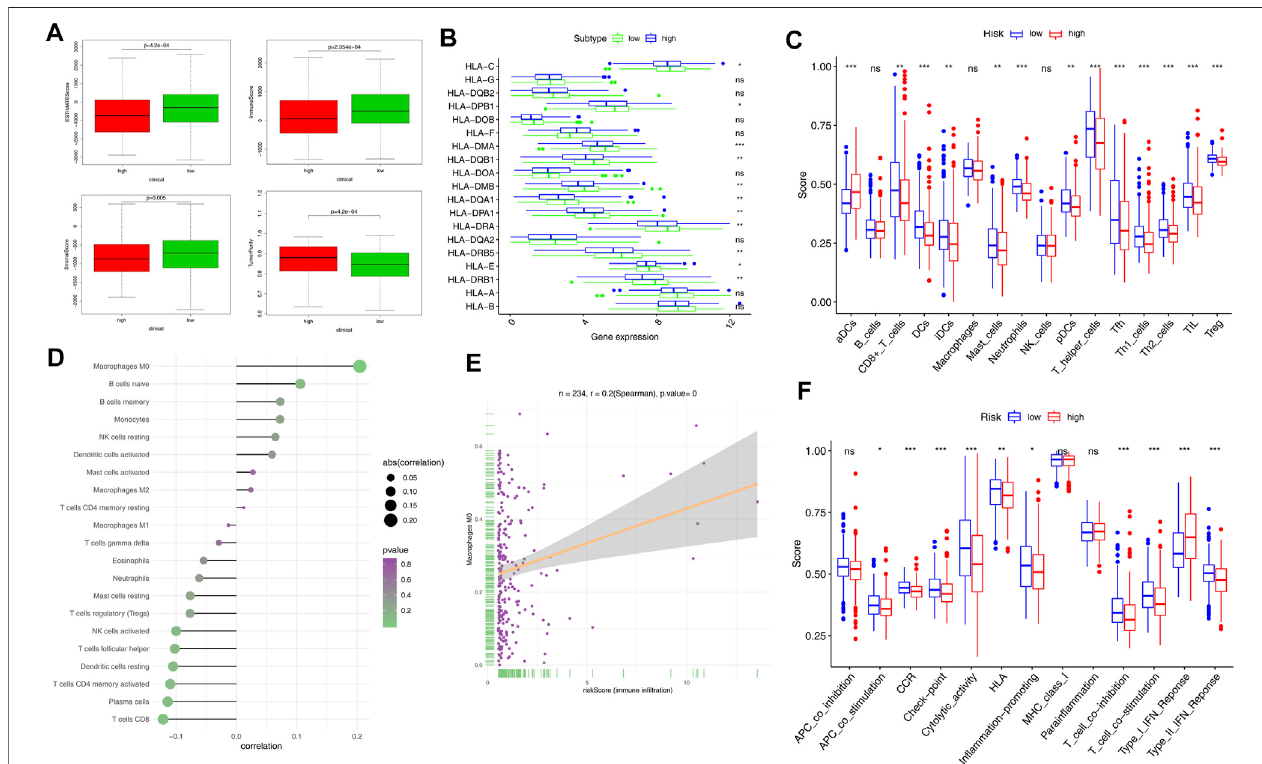
FIGURE 6 | Comparison of immune signature between the high- and low-risk groups of patients with EC. (A) Comparison of ESTIMATES score, immune score, stromal score, and tumor purity in the high- and low-risk groups. (B) Expression of HLA-related genes in different risk groups. (C) Comparison of tumor-in fi ltrating immune cells (TIICs). (D) Correlation of risk score and TIICs. (E) Association of Macrophages M0 and risk score (immune in fi ltration). (F) Scores of 13 immune-related functions in the high- and low-risk groups. Adjusted p -values were shown as follows: ns, not signi fi cant; * p < 0.05; ** p < 0.01; and *** p < 0.001.